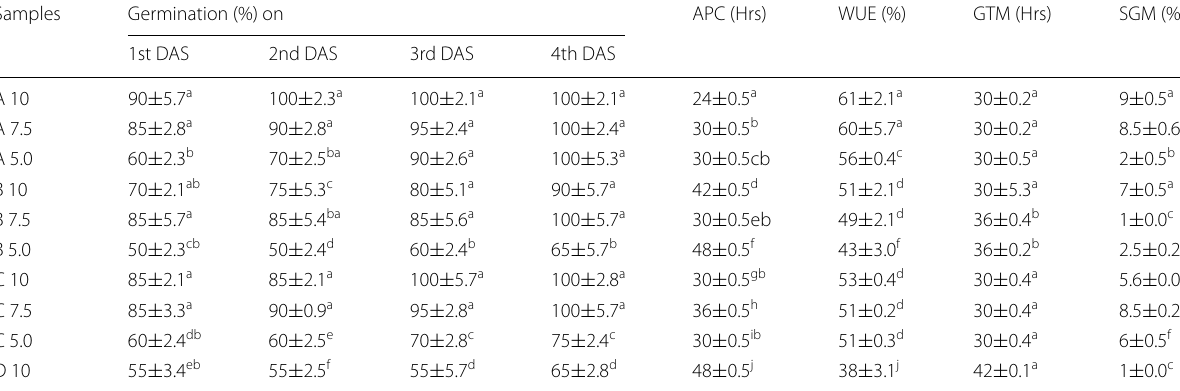
Results with similar alphabetic superscripts on same column did not differ from each other (p>0.05). Results were in mean and standard error of four replicates. DAS Day after sowing, APC = of Klebsiella sp ., respectively. D10